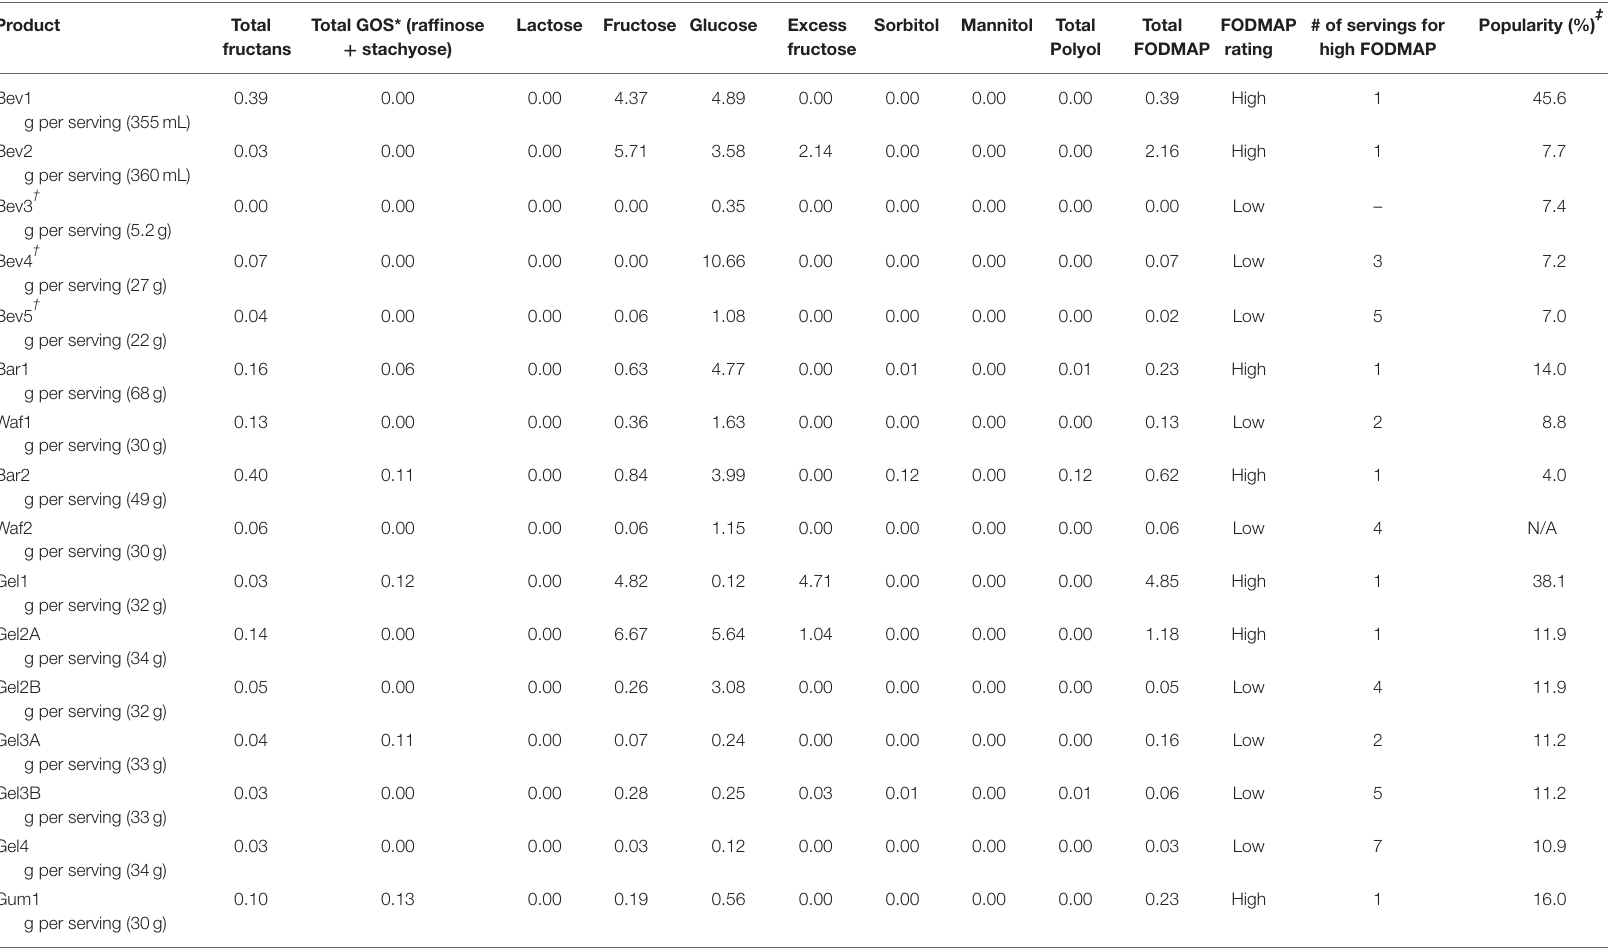
TABLE 3 | Specific fermentable oligosaccharides, disaccharides, monosaccharides, and polyols (FODMAP) composition of commonly used beverage, solid, and gel/gummy products. Product